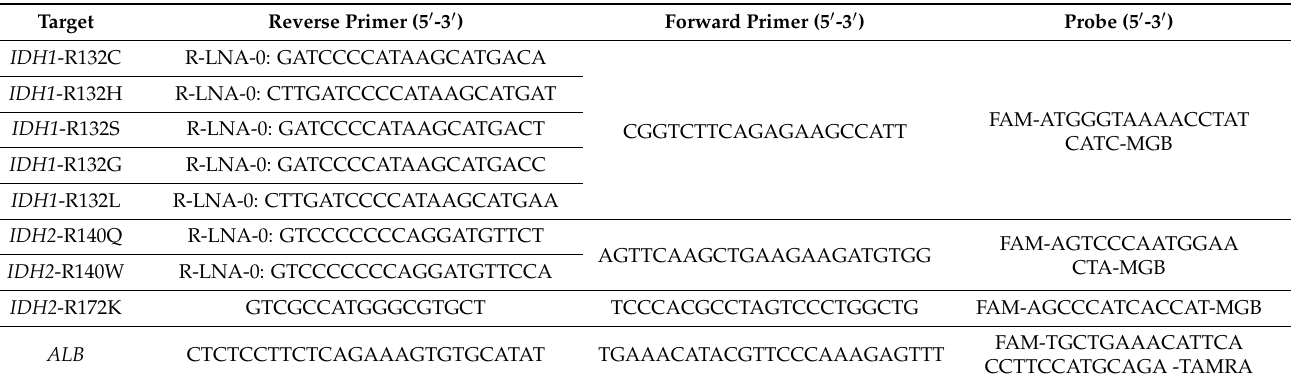
Table 1. Probes, forward primers, and reverse